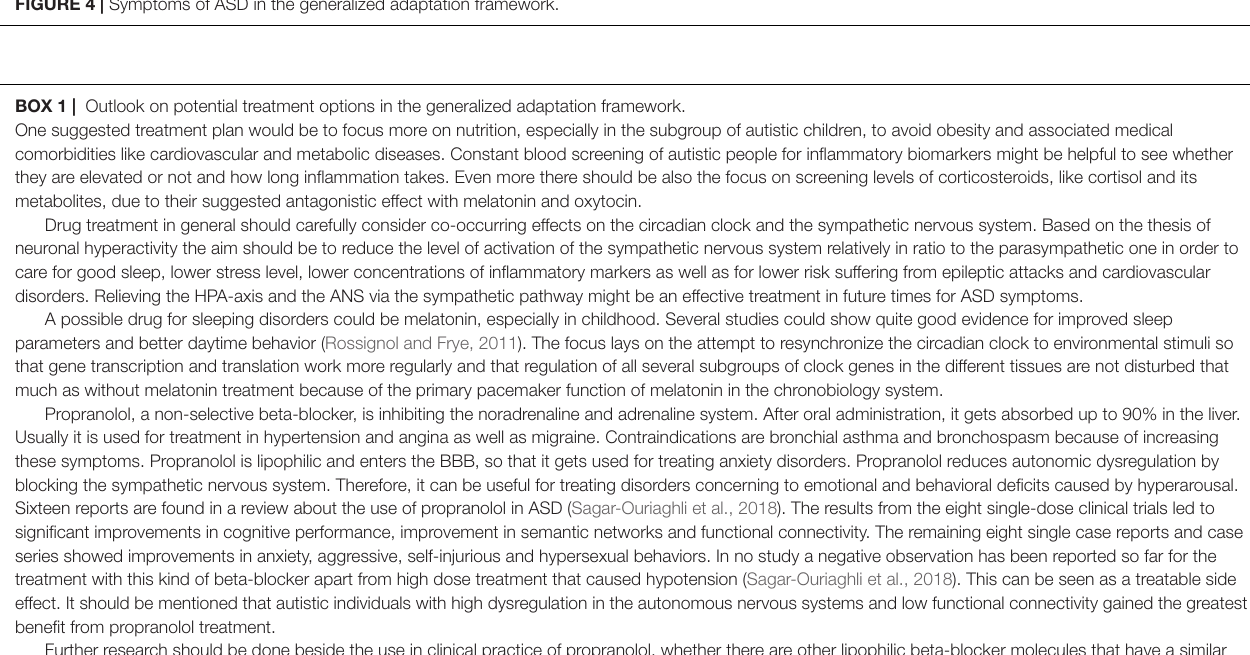
FIGURE 4 | Symptoms of ASD in the generalized adaptation